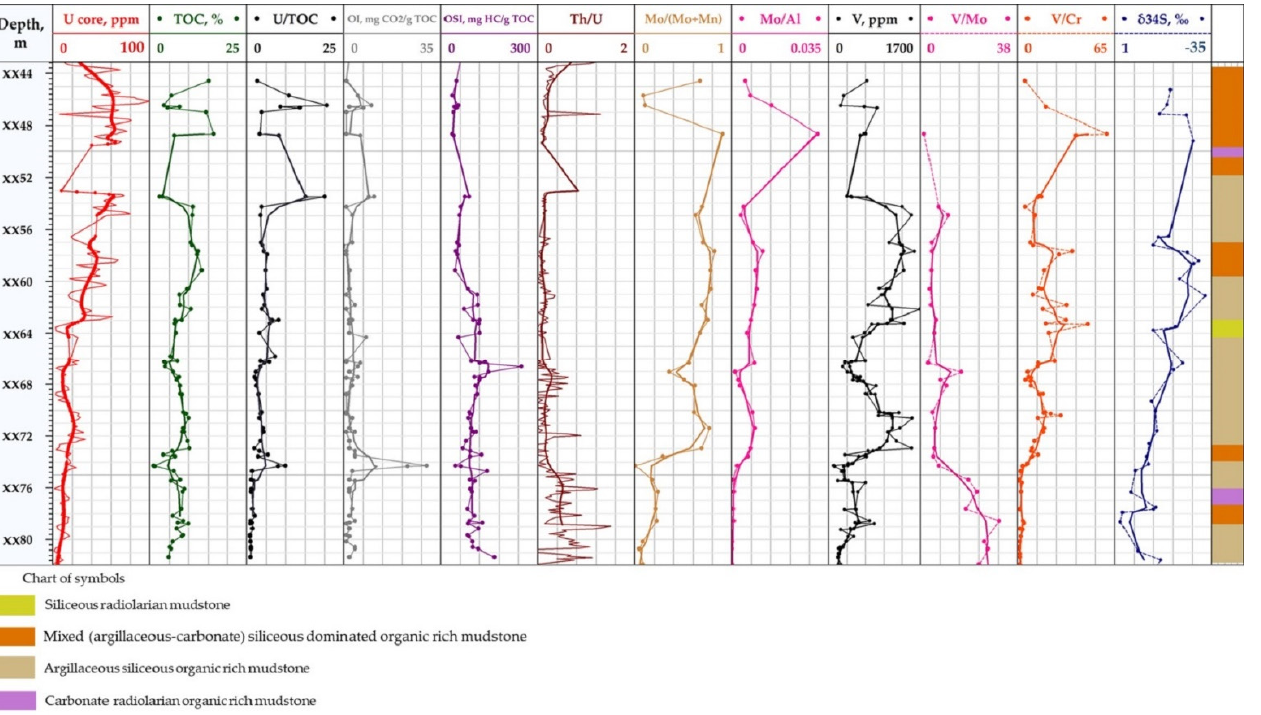
Figure 2. Logview well 1: U, Th/U, TOC (total organic carbon), OI (oxygen index), OSI (oil saturation index), U/TOC, V, V/Mo, V/Cr, Mo/Al, and Mo/(Mo + Mn), δ 34 S (sulfur isotopic composition).